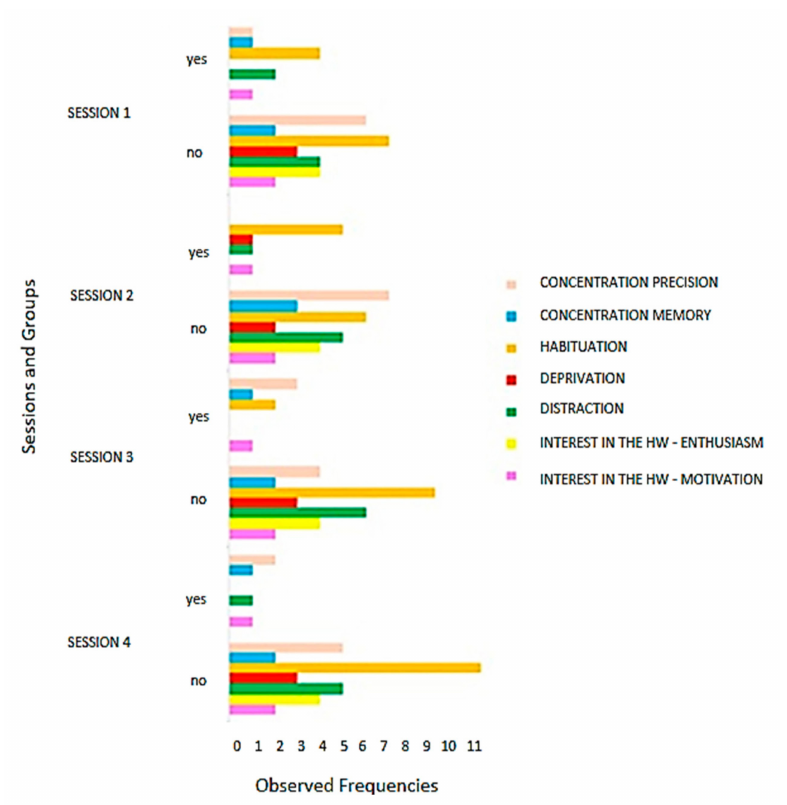
Figure 7. Comparison of the observed behaviour